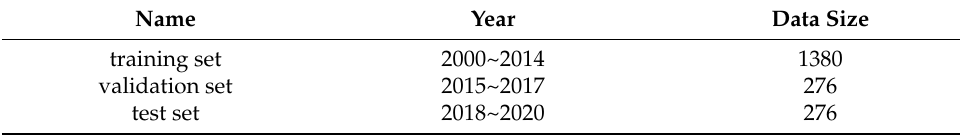
Table 4. The partition of the